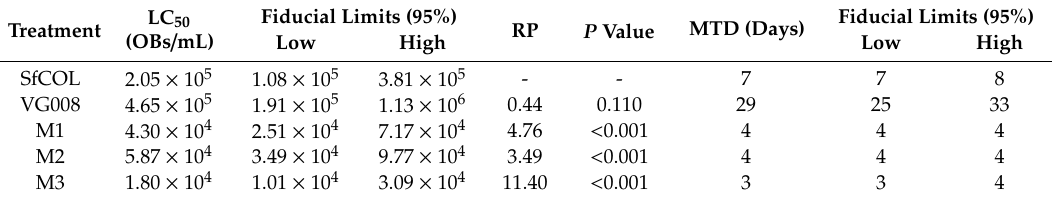
Table 2. Estimated LC 50 values, relative potencies (RP) and mean time to death (MTD) values of SfCOL and VG008 mixtures in S. frugiperda second instar